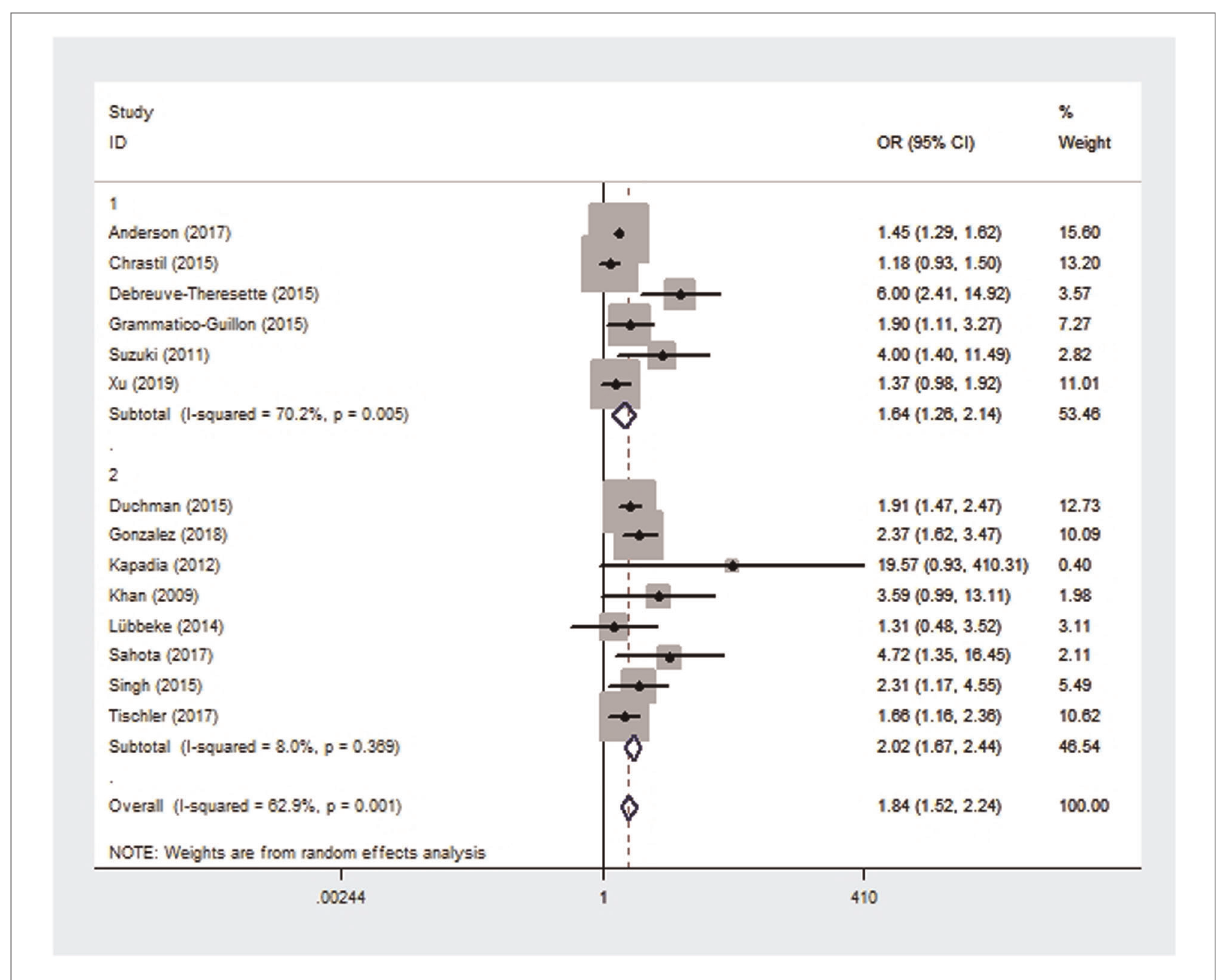
FIGURE 3 Forest plot of subgroup analysis for prosthetic joint infection based on study type (1: case-control study; 2: cohort